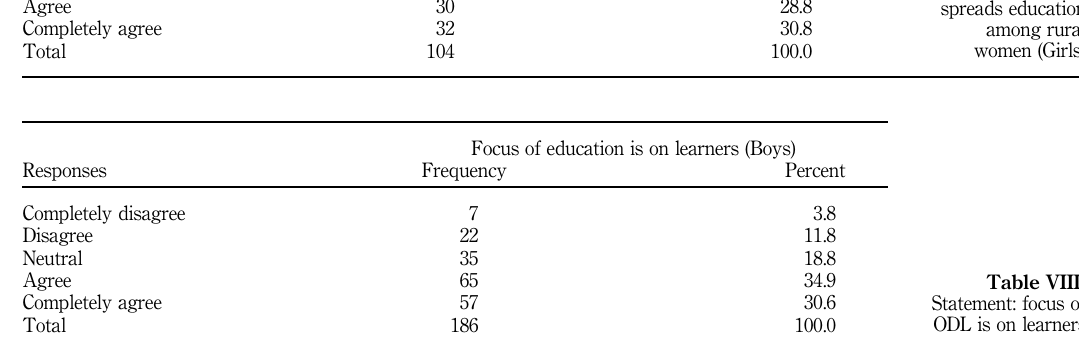
Table VII. Statement: ODL